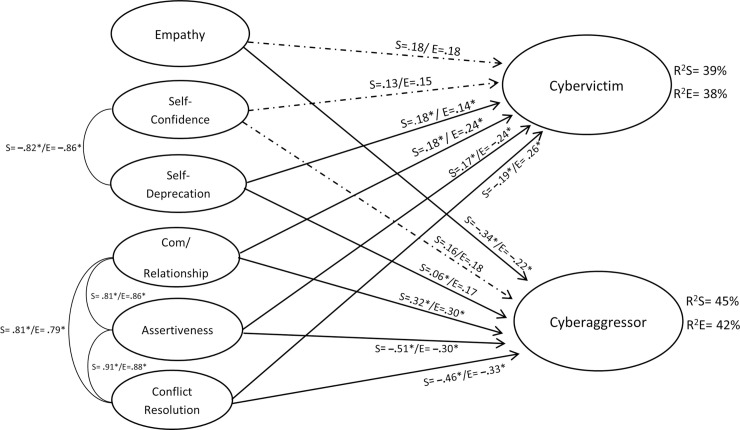
Model for the sample from Ecuador and Spain.E = Ecuador; S = Spain.